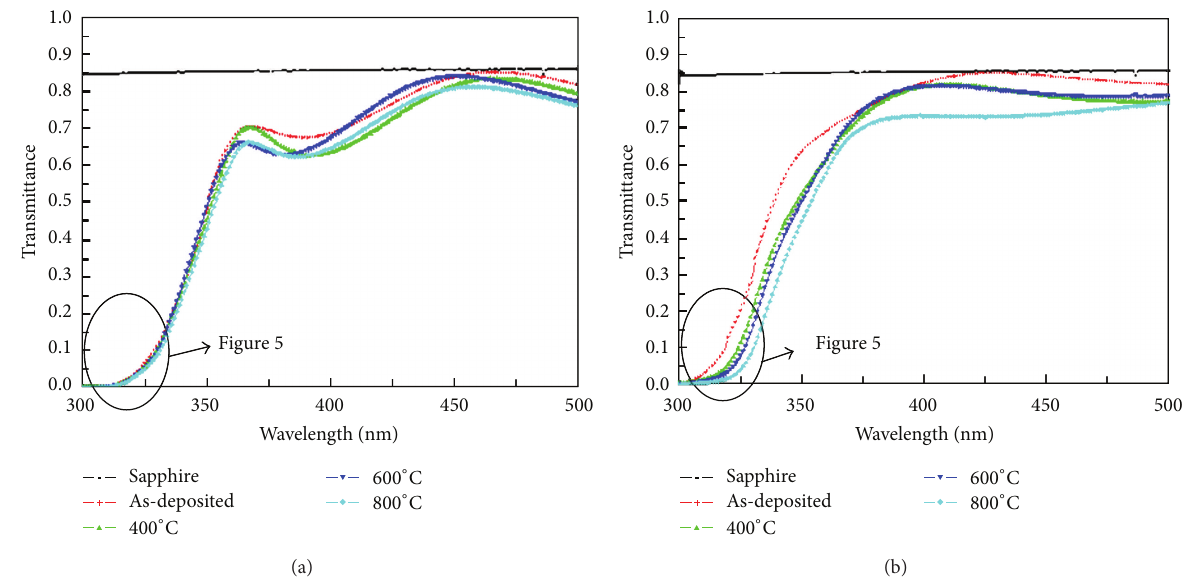
Figure 1: Transmittance spectra obtained from (a) Ti 3 O 5 and (b) TiO 2 starting materials at various thermal annealing temperatures.